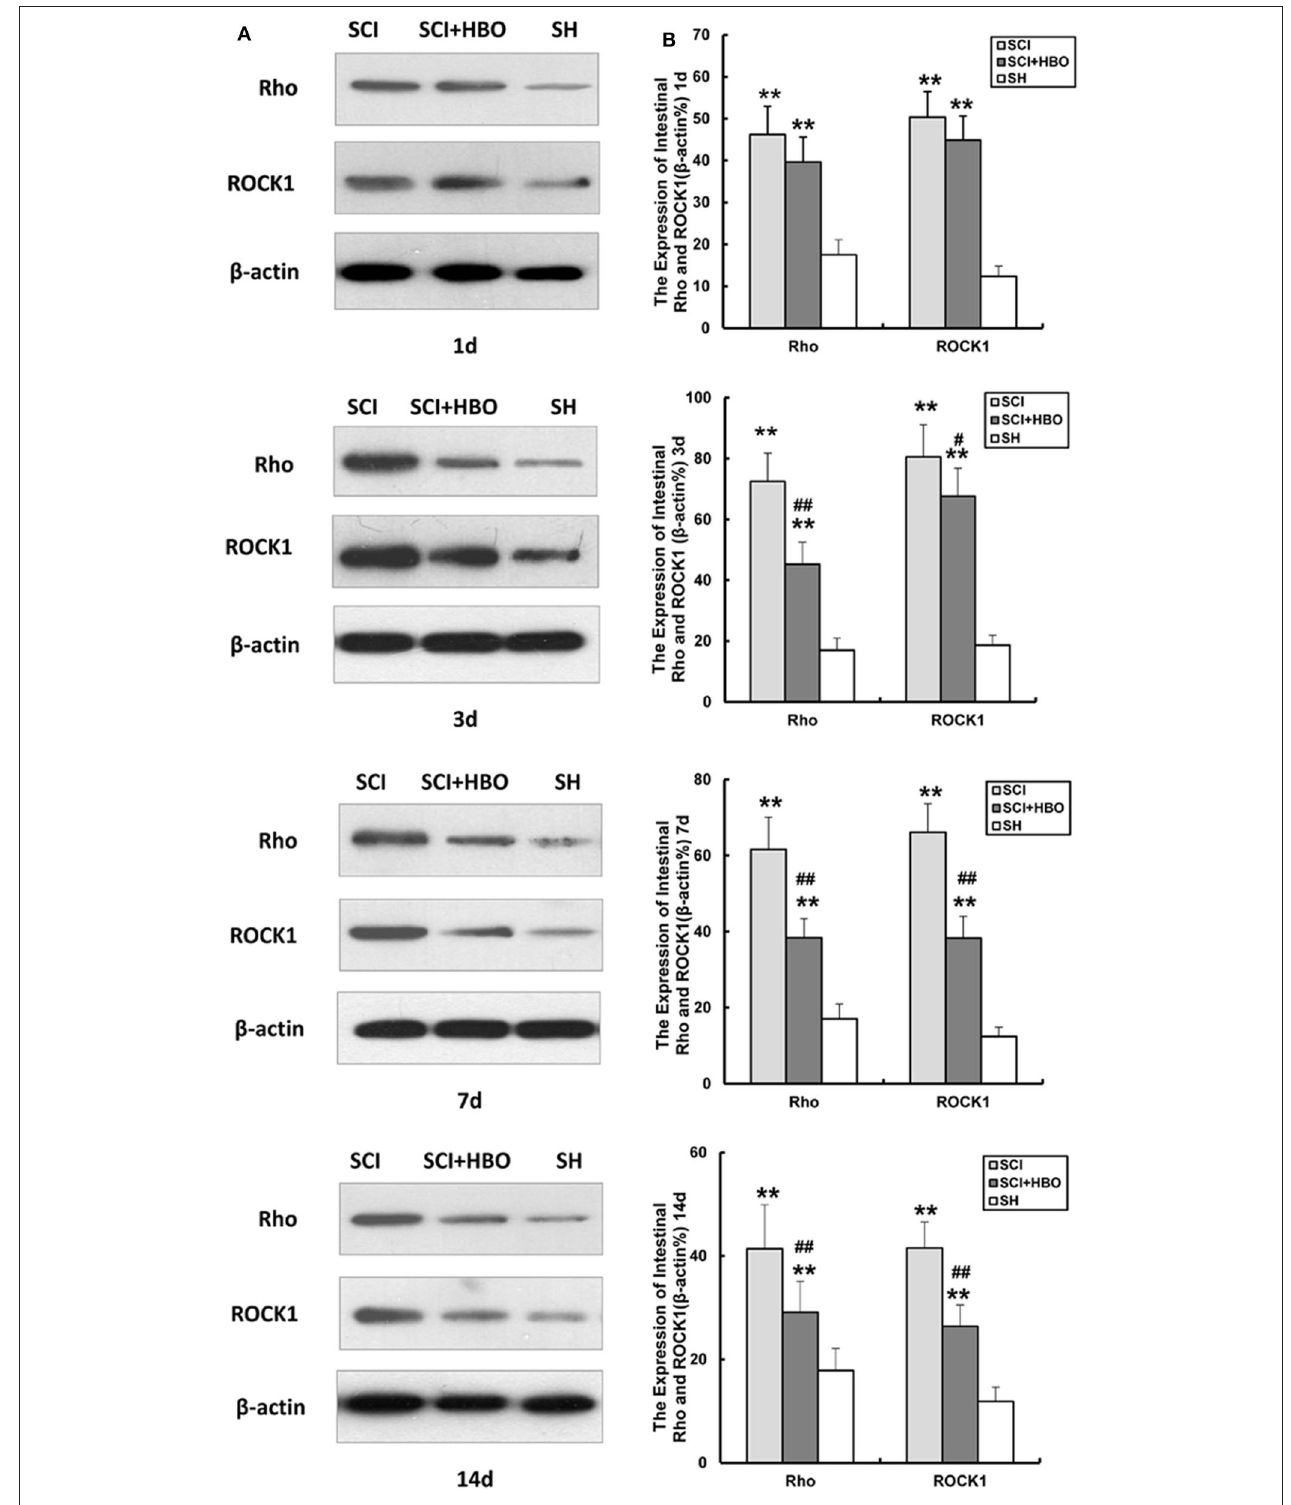
FIGURE 6 | Effect of HBO on Rho and ROCK1 protein expression in jejunum tissue after SCI. (A) Representative immunoblot of two factors at different time points postoperatively. (B) Analysis of two factors of protein expression. Data are presented as mean ± SD. Compared with the SH group, the protein expression of two factors significantly increased in the SCI and SCI + HBO groups (** P < 0.01); HBO treatment significantly decreased their protein expressions compared with the SCI group ( # P < 0.05, ## P < 0.01). HBO, hyperbaric oxygen; SCI, spinal cord injury; SH, sham operation.